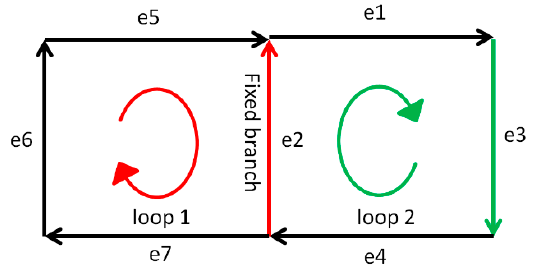
Figure 6. Division of the closed loops with a fixed airflow branch.